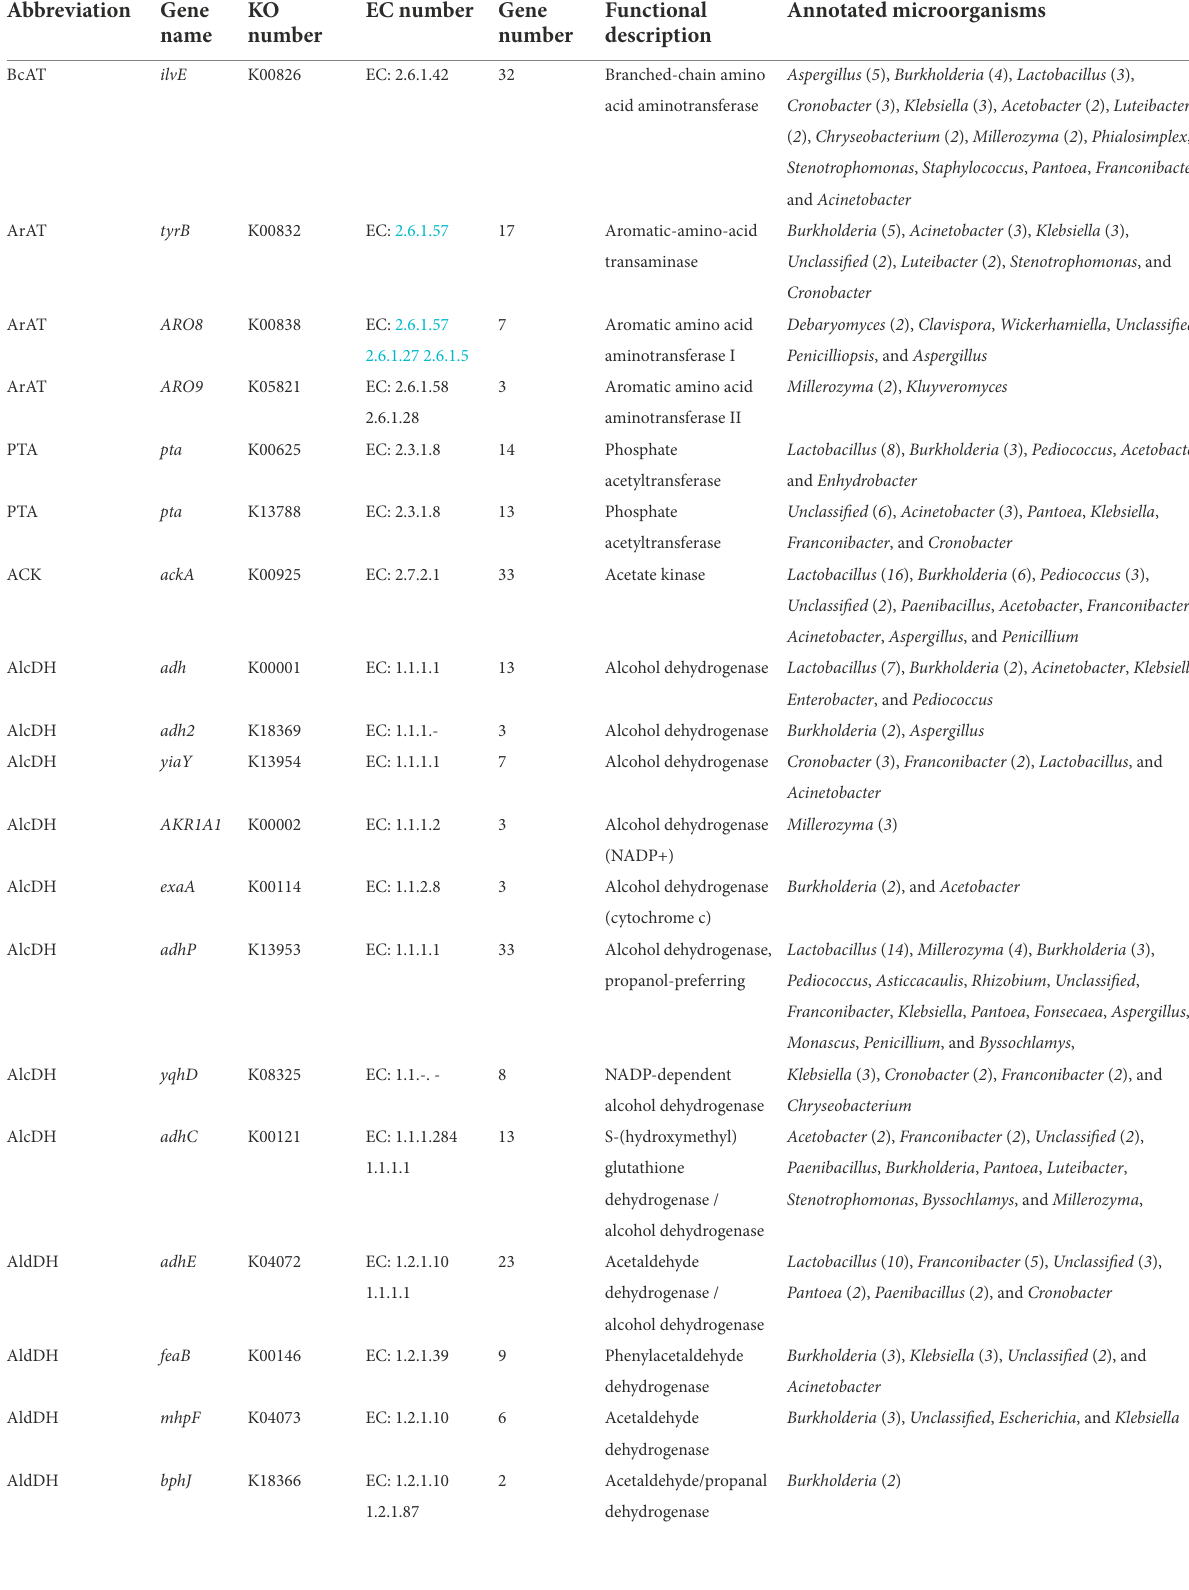
TABLE 3 Genes of encoding enzymes involved in transamination pathway in red vinasse